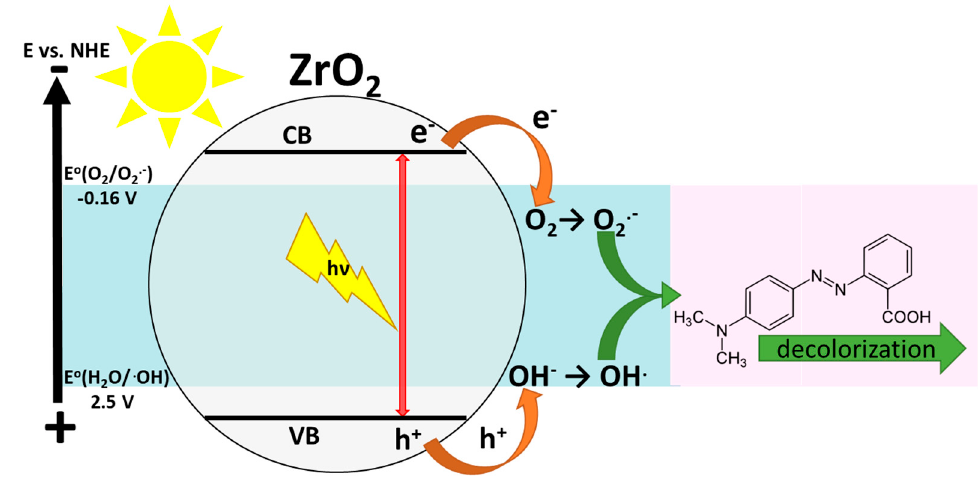
Figure 5. Proposed reaction mechanism of the heterogeneous photocatalytic decolorization of MR at illuminated ZrO 2 .